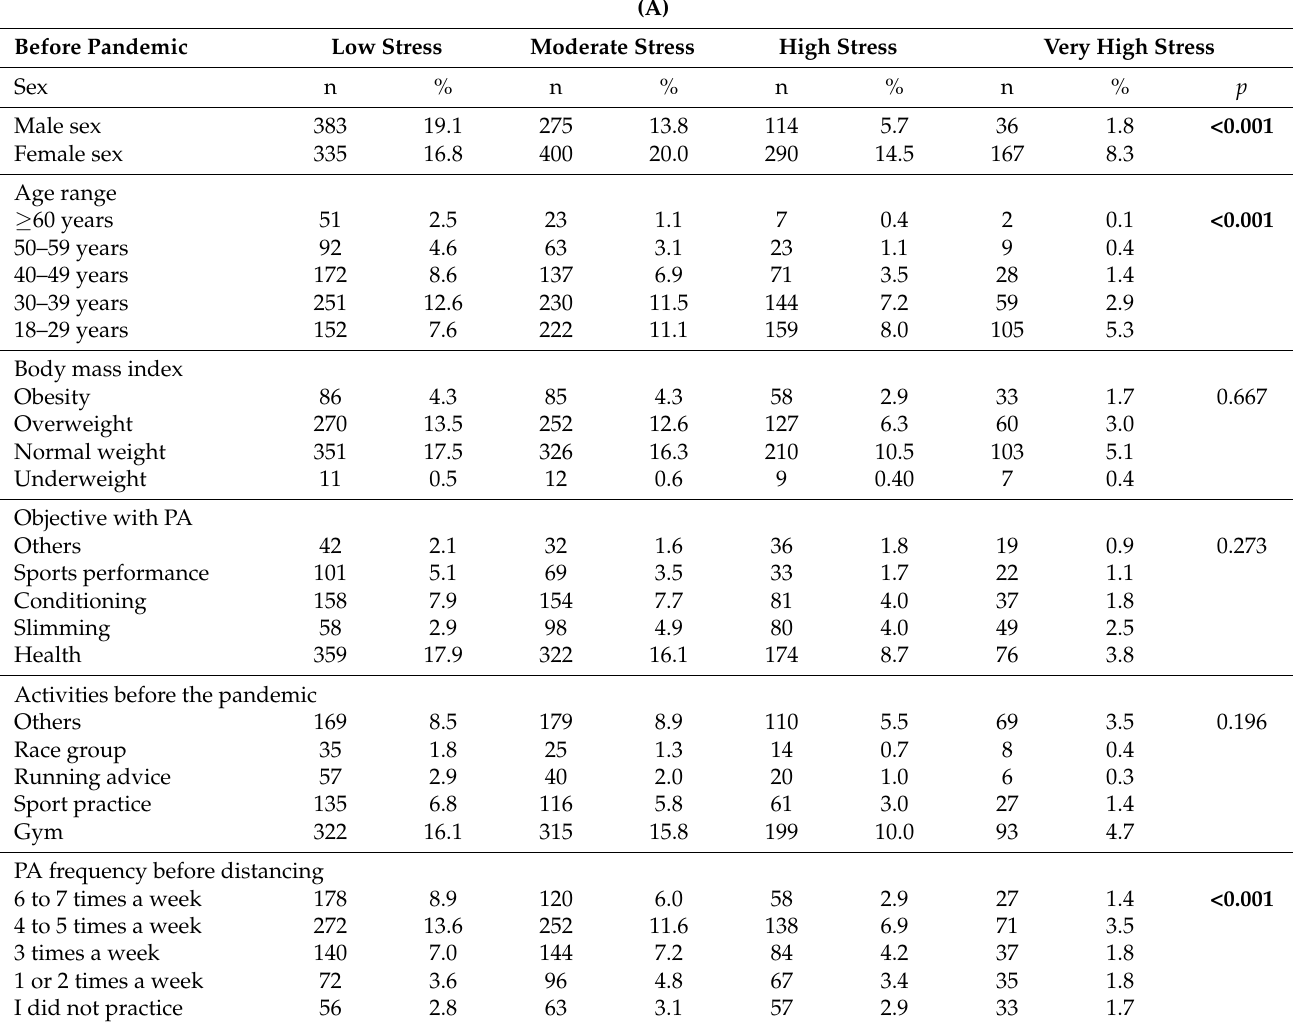
Table 1. ( A ) Characteristics of the sample of Brazilians included in the study according to psycho- logical distress (anxiety and depression) before social distancing (N = 2000). ( B ) Characteristics of the sample of Brazilians included in the study according to psychological distress (anxiety and depression) during social distancing (N =